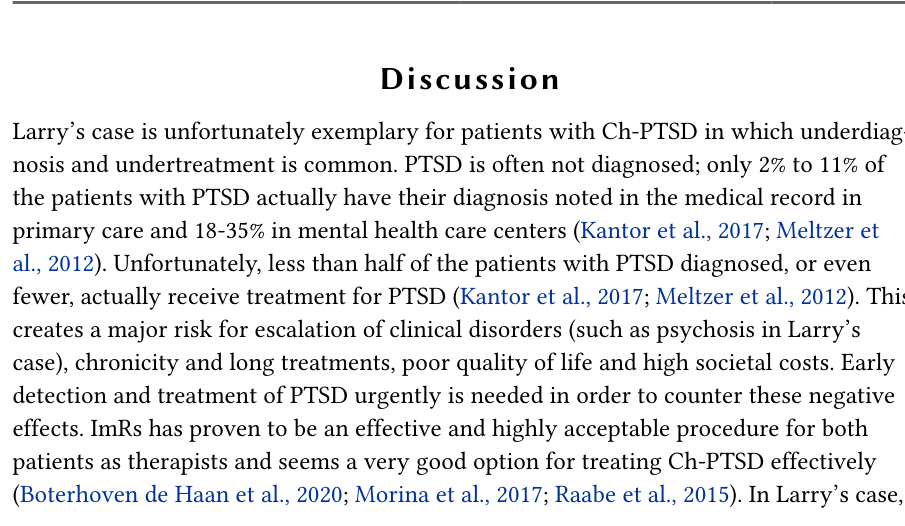
Results on Outcome Measures at Baseline, After Completion of ImRs and Follow up Measure Baseline Clinician Administered PTSD Scale for DSM-5 (Weathers